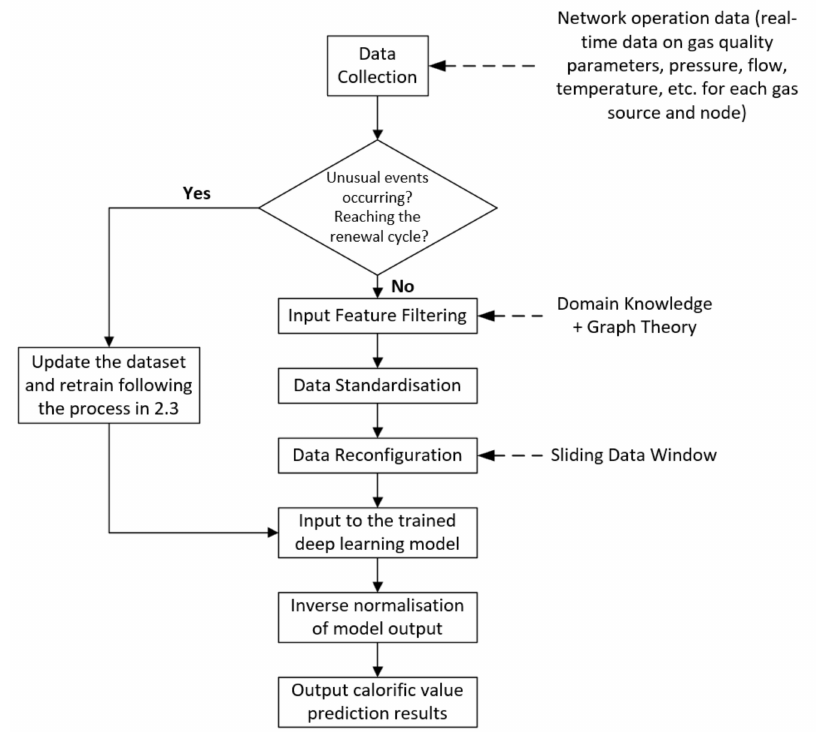
Figure 4. The flowchart of dynamic prediction method of calorific value based on deep learning.